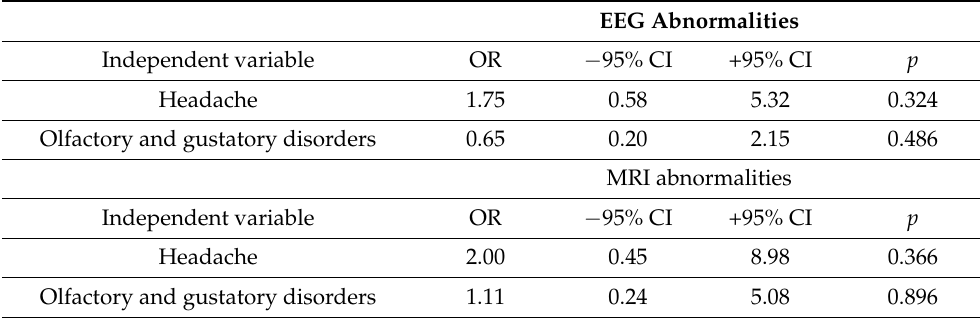
Table 1. The odds ratio of mild neurological symptoms coinciding with EEG and MRI abnormalities.